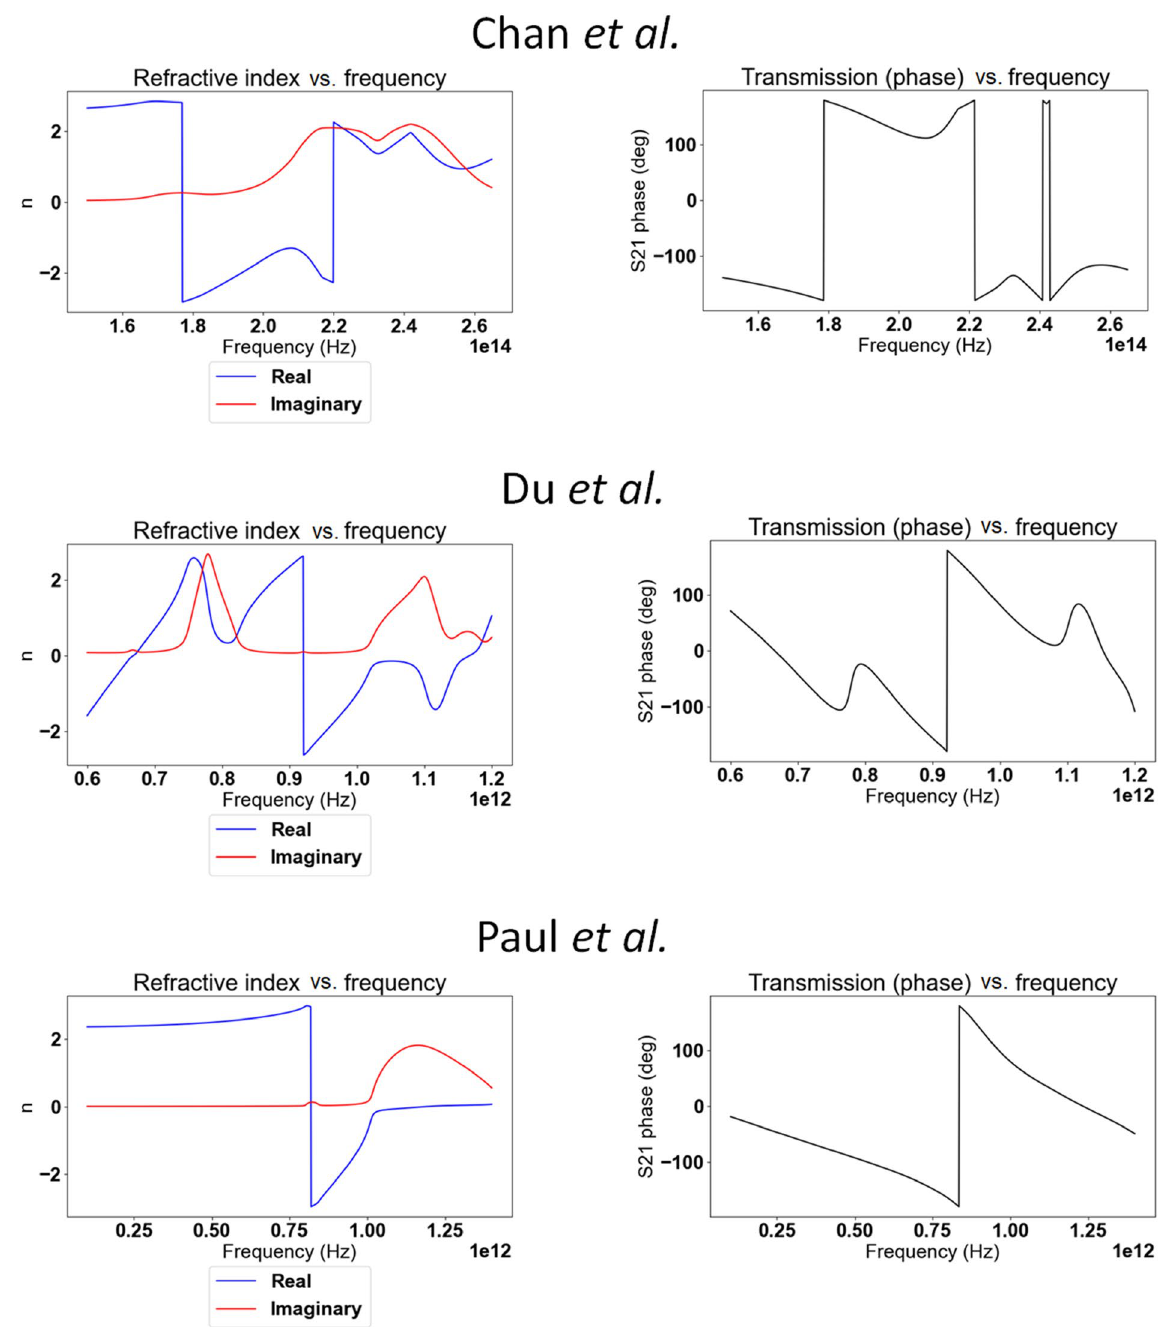
Figure 15. Comparison of numerical results of, from top to bottom, Chan et al.’s, Du et al.’s and Paul et al.’s metamaterials refractive index (left) and transmission phase (right). To note, Chan et al.’s refractive index is represented as obtained by misuse of the NRW